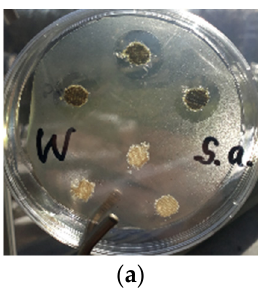
Table 2. Bactericidal activity of modified wool and cotton samples against S.